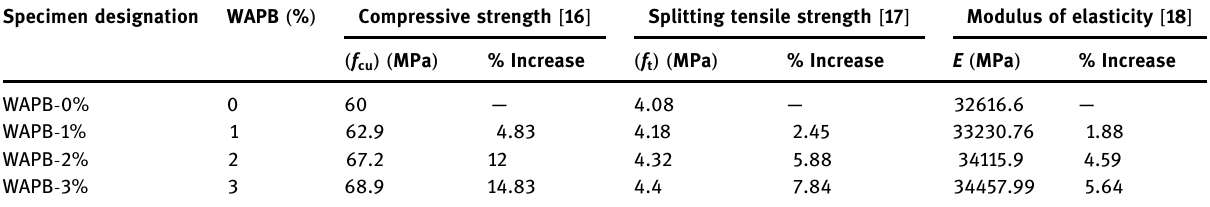
Table 10: Details the specimens that were tested